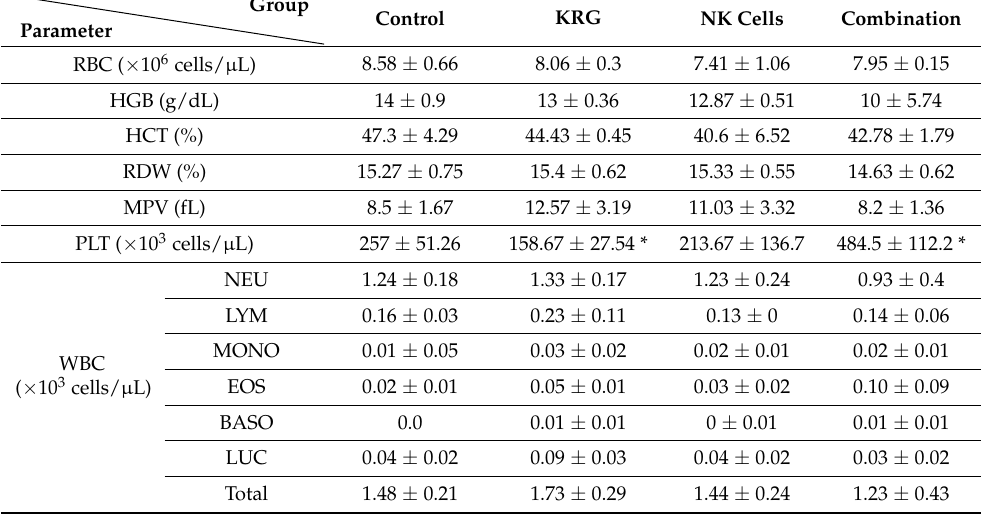
(Table 1). NK cell treatment produced no change in blood composition, while KRG treat- ment decreased the number of platelets. Conversely, the combination of KRG and NK cells increased the number of platelets. On the other hand, the white blood cell (WBC) count increased in KRG treatment, and decreased in the combination of KRG and NK cells, although these results showed no significance. In the combination of KRG and NK cells, the percentages of neutrophils and eosinophils were significantly decreased and increased, respectively (Figure 4A). These results suggest that KRG regulates hematological parameters in tandem with NK cells. Table 1. Hematological analysis. Parameter